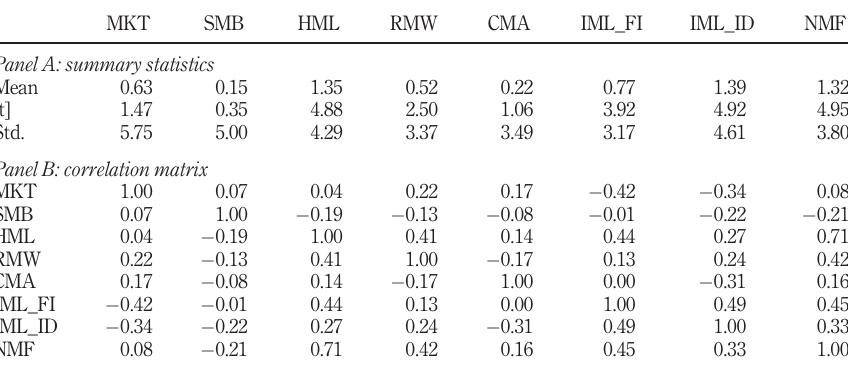
Table 2. Returns on main factors